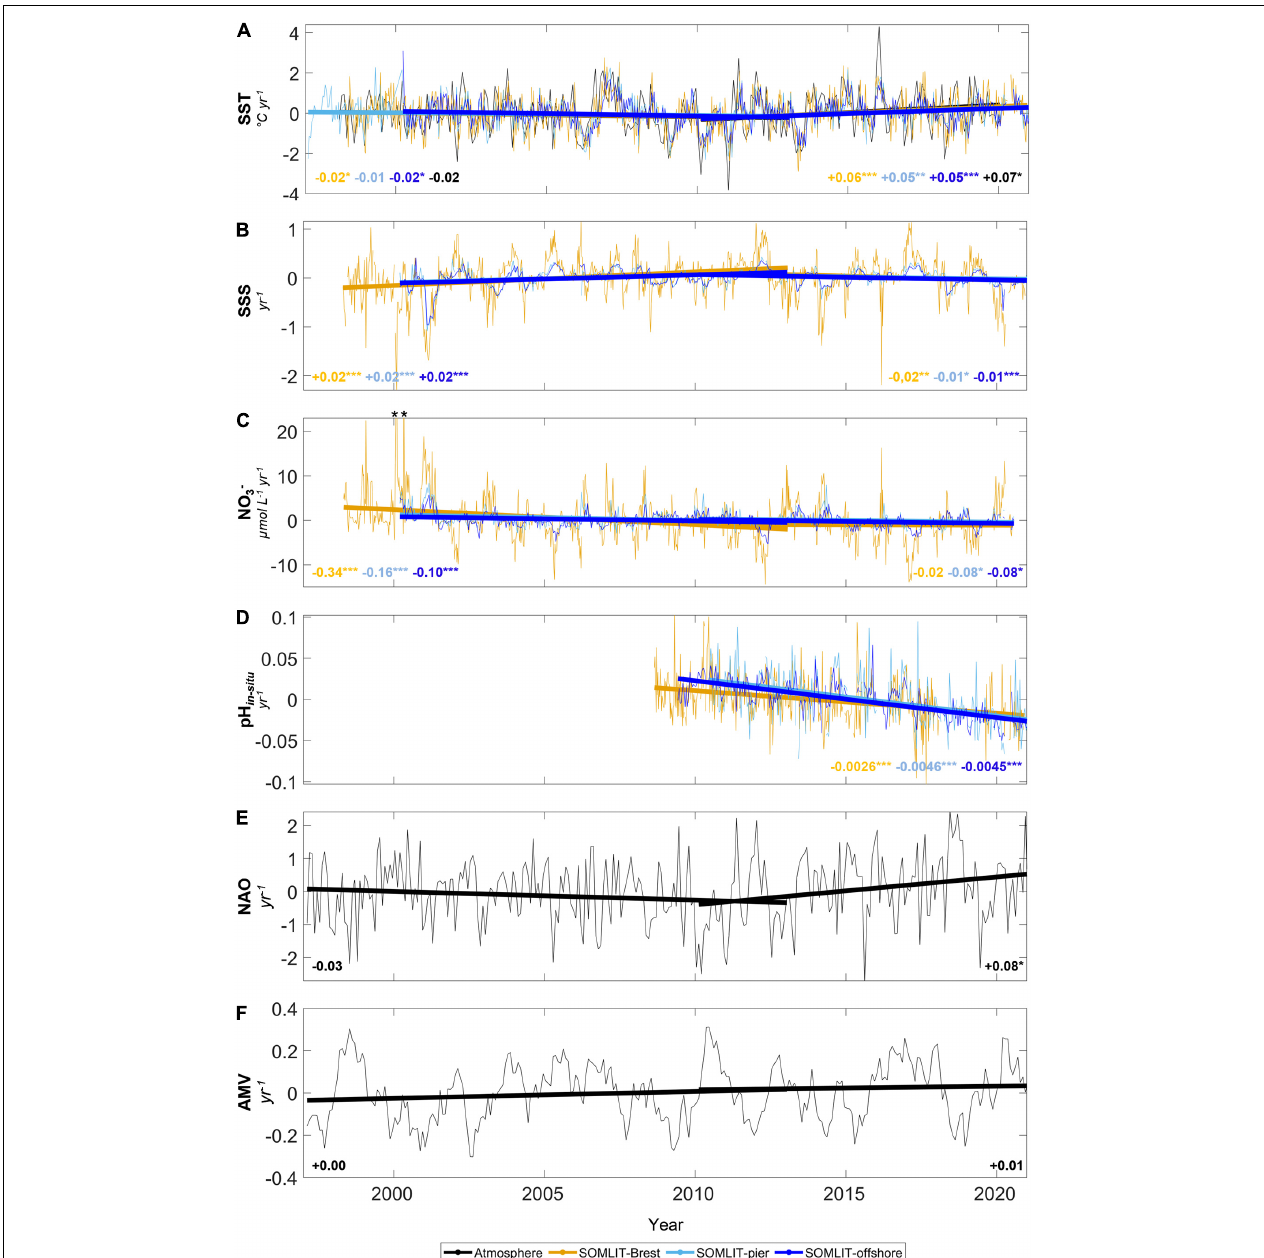
FIGURE 10 | Trends of monthly anomalies of (A) SST ( ◦ C year − 1 ), (B) SSS (year − 1 ), (C) nitrate ( µ mol L − 1 year − 1 ), and (D) pH in situ (year − 1 ) at (orange) SOMLIT-Brest, (light blue) SOMLIT-pier, and (dark blue) SOMLIT-offshore, and monthly values of (E) NAO and (F) AMV climatic indices. Trends were divided into two periods separated by the slope break detected around 2009–2011 with the STL (Cleveland et al., 1990) applied to the SST time series over the 1998–2020 period (see Section “Comparison of OA Trends and Climatic Context Over the 1997–2020 Period” for details). Asterisks represent p -values: *** p -value < 0.001, ** p -value < 0.01, * p -value < 0.05, and no asterisk indicates non-significant trends.